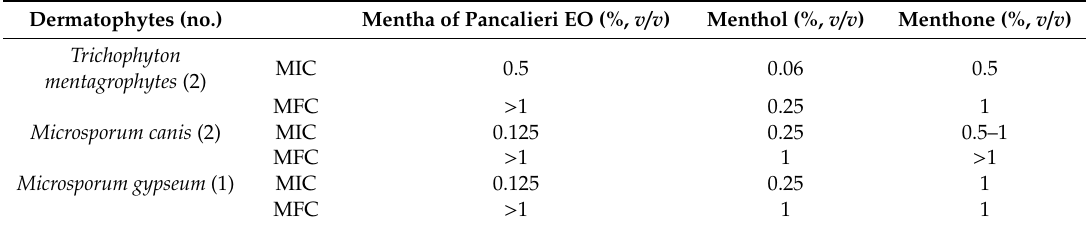
Table 3. MIC 1 and MFC 2 ranges of menthol and menthone, the main components of “Mentha of Pancalieri” essential oil towards dermatophytes clinical strains. Dermatophytes